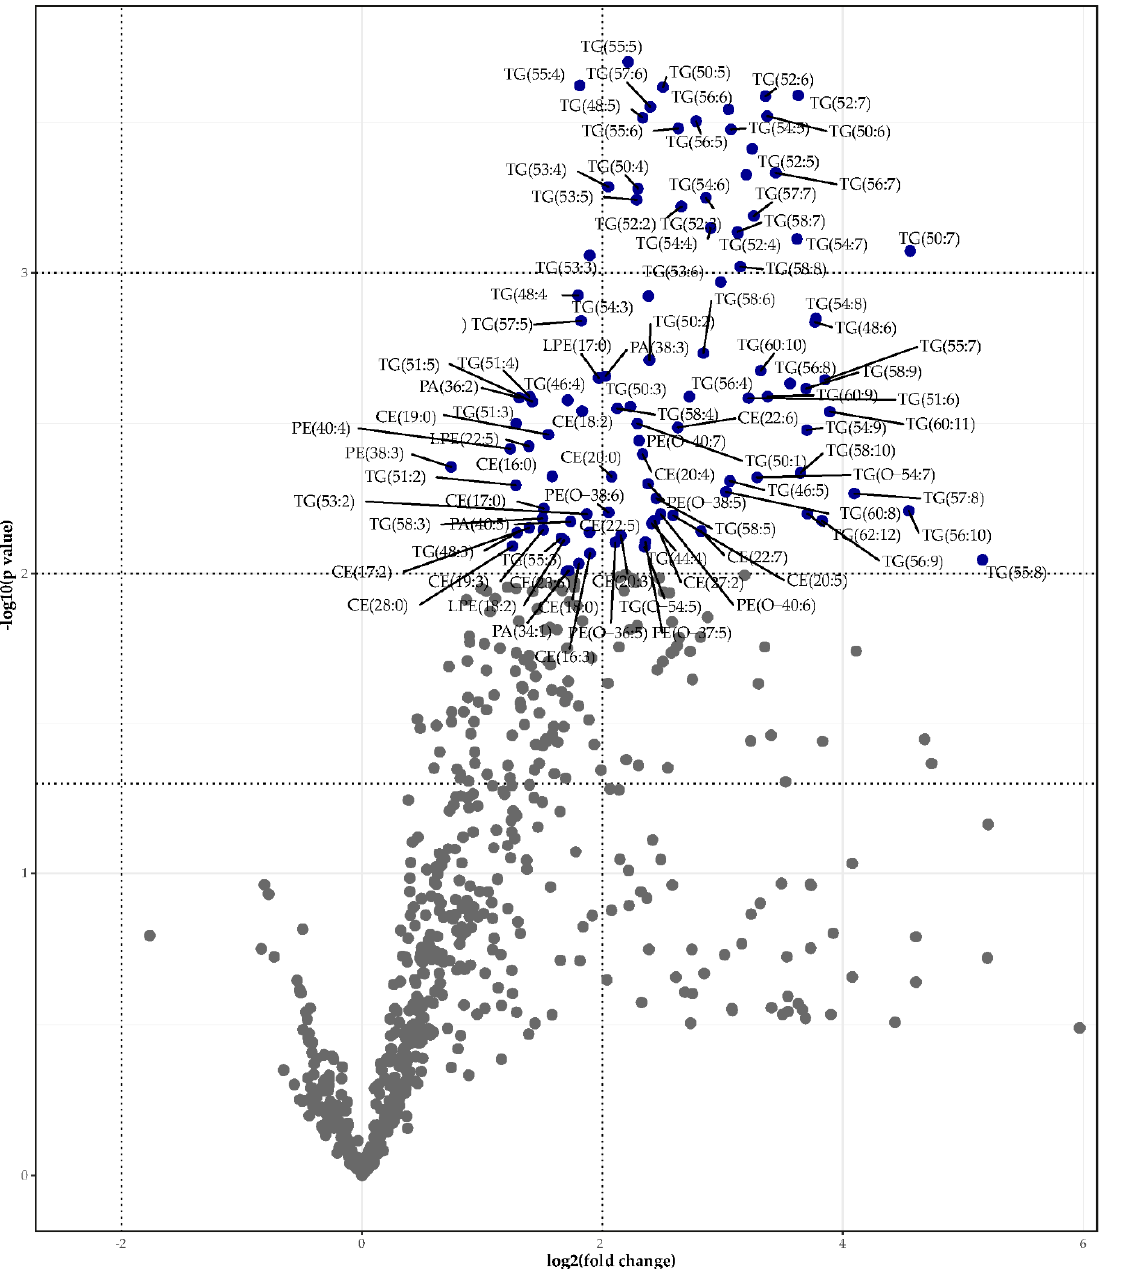
Figure 4. Volcano plot (significance (-log10( p -value)) versus effect size (log2(fold change)) depicting the lipidomics data. The most discriminative lipid species based on p -value are labeled. The three horizontal lines indicate p -values of 0.05, 0.01, and 0.001, respectively. The two vertical dotted lines indicate log2(fold change) of − 2 and 2, respectively.